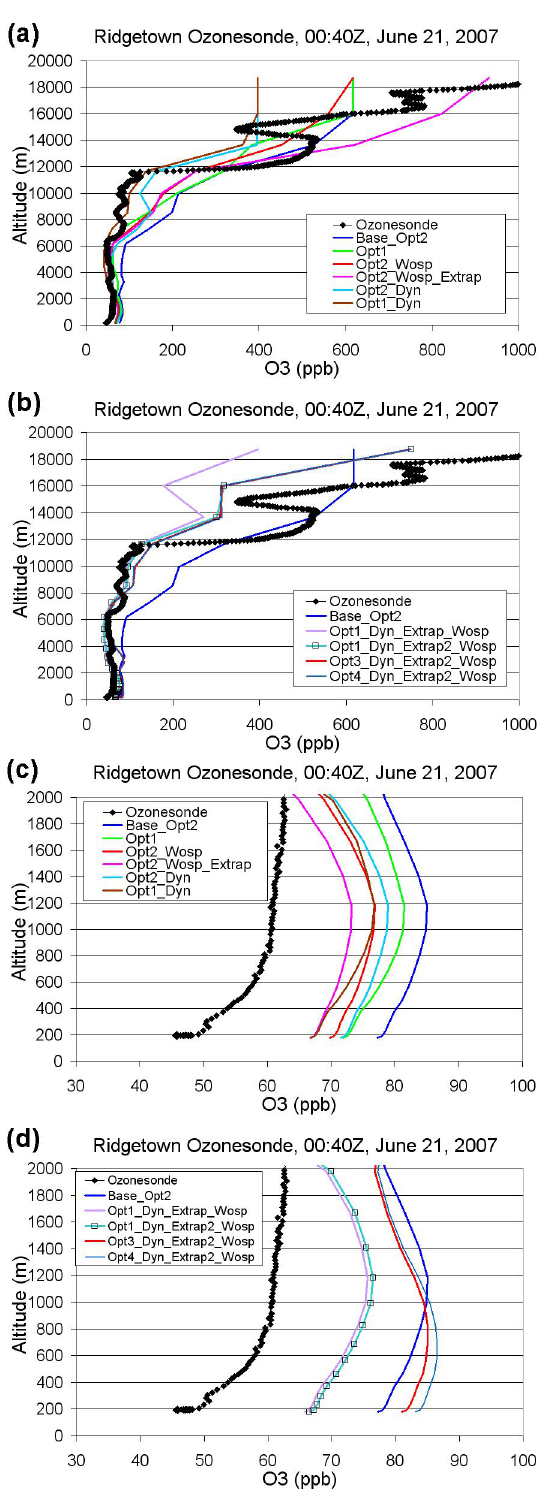
Fig. 7. (a) and (b) : Comparison between observed ozone profile and 12km grid simulations, 13:00Z, 25 June 2007. (a) Entire model vertical domain, first five scenarios. (b) Entire model vertical do- main, second five scenarios. (c) and (d) As in (a) and (b), lowest 2km of the